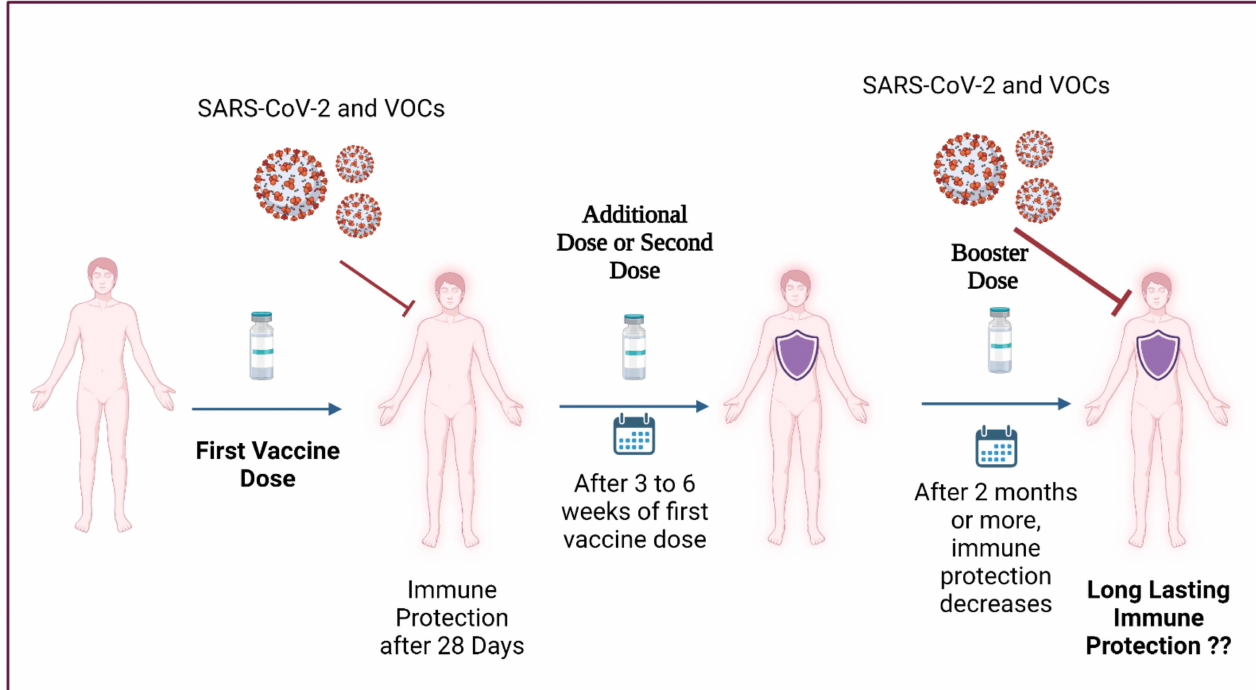
Figure 1. The booster dose strategy against omicron and other VOCs of